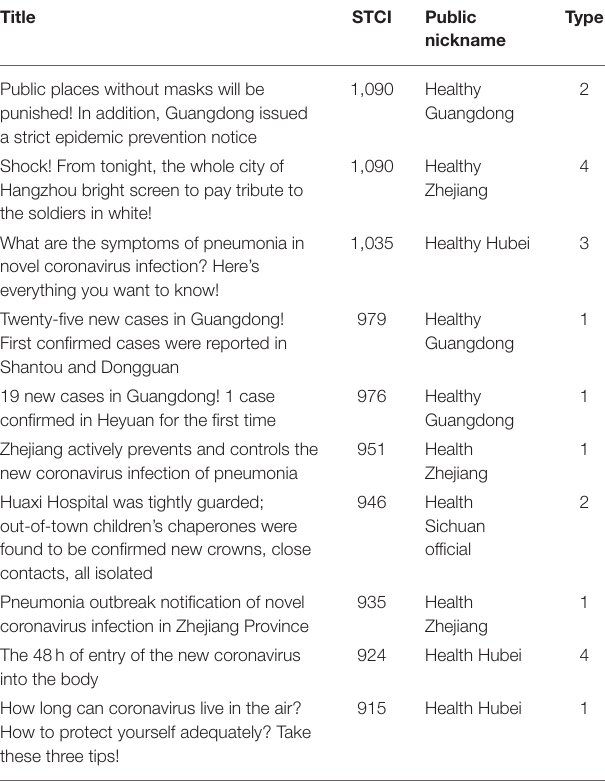
TABLE 6 | High-STCI WeChat official account tweets’ statistics (partial).